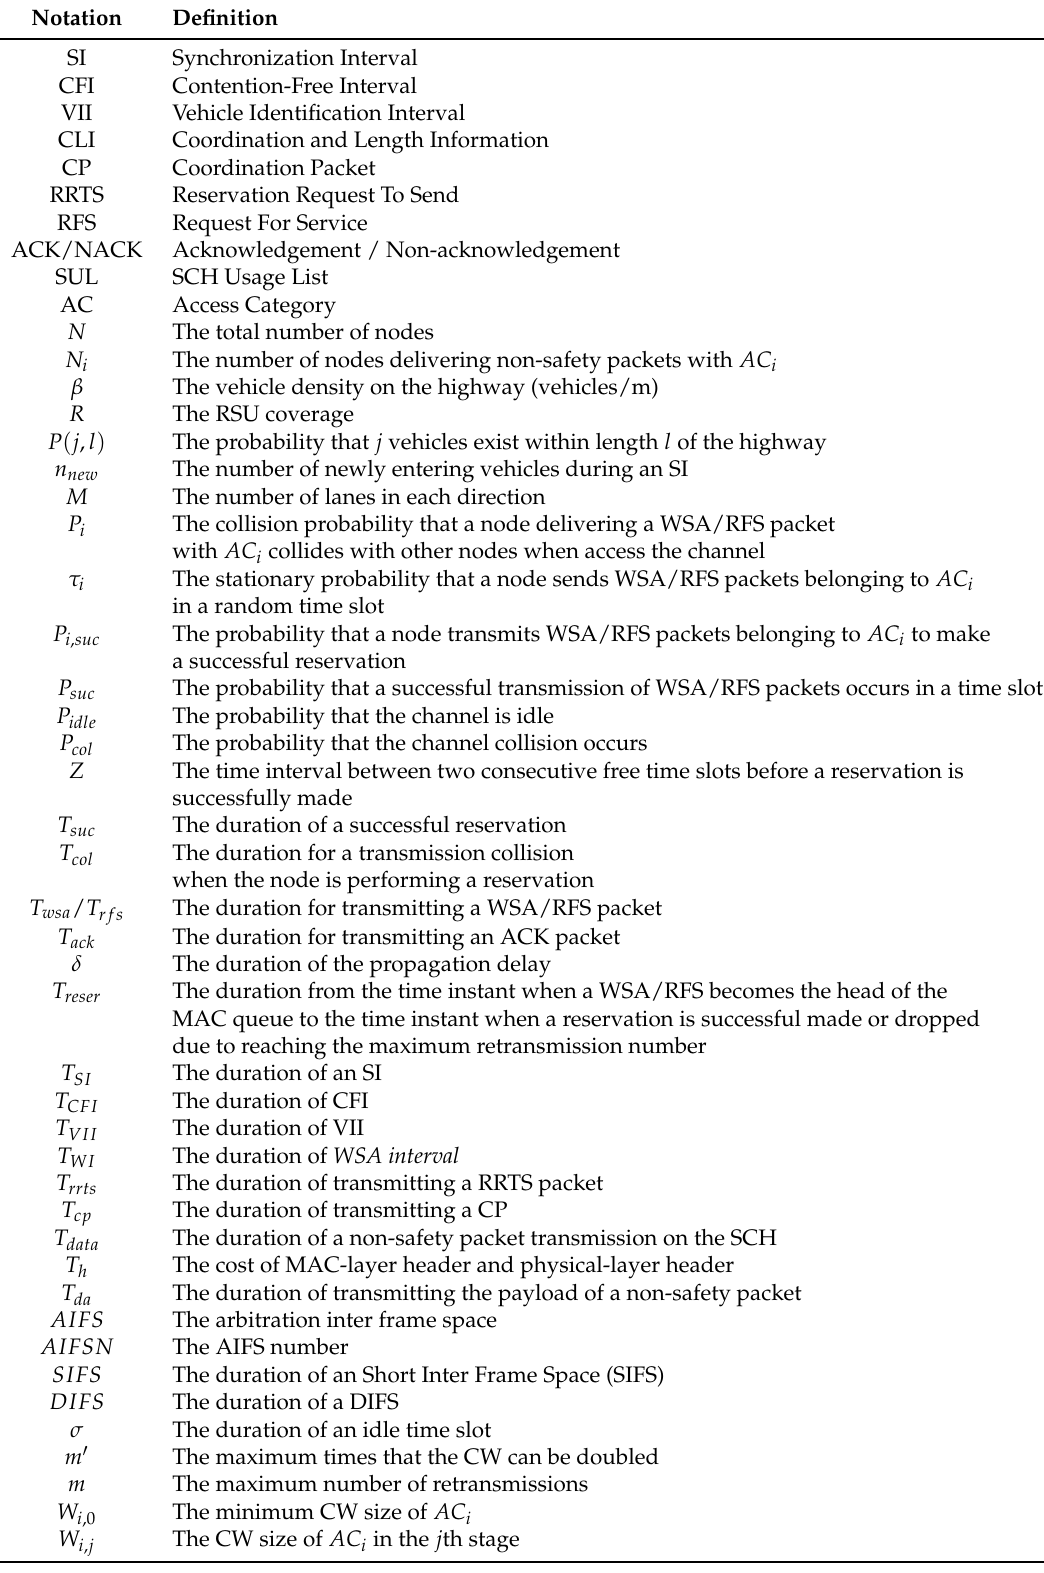
Table 1. Summary of important